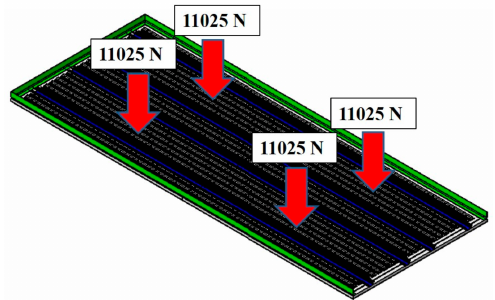
Figure 11. Load case 1 for structural analysis.